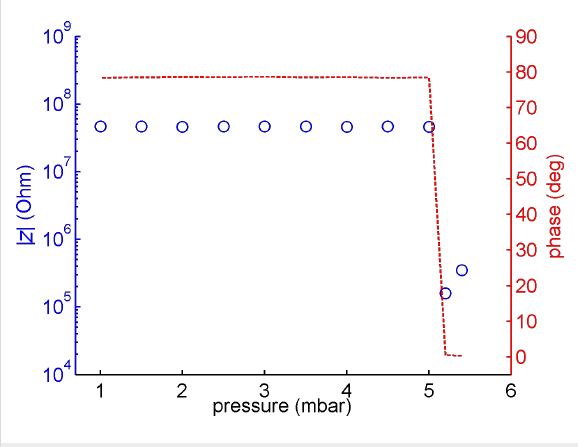
Figure 4: Impedance and phase measured at 1 kHz across the nanoporous membrane versus driving pressure for the microfluidic cell. A stable bilayer exhibits capacitive behavior at high impedance.